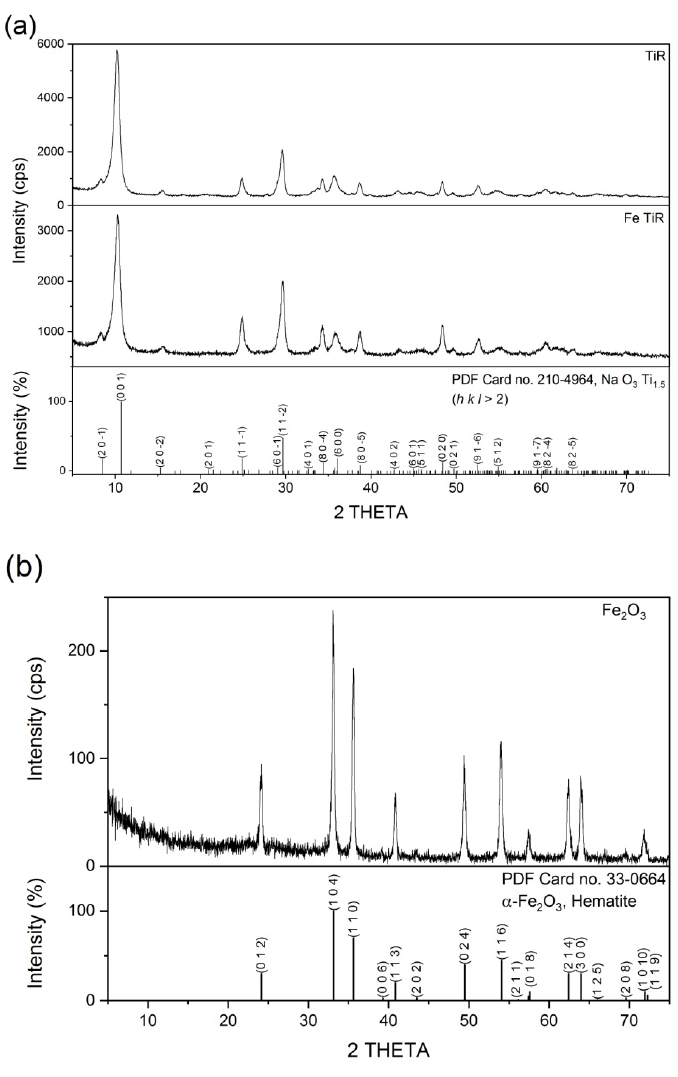
Figure 2. XRD pattern of ( a ) titanate nanorods: pristine TiR and FeTiR ( b ) Fe 2 O 3.